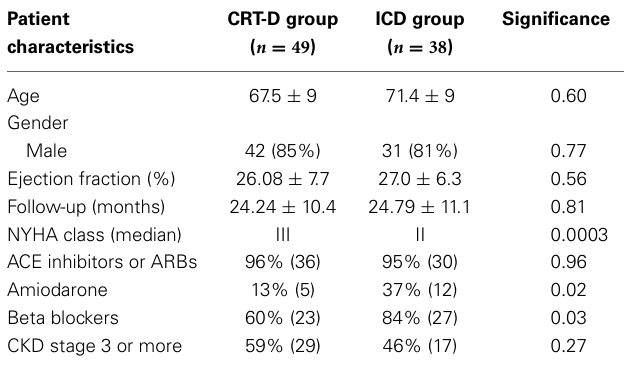
FIGURE 7 | Kaplan Meyer survival analysis of the occurrence of VT/VF between ICD and CRT-D groups in the Non-Ischemic Cardiomyopathy patient